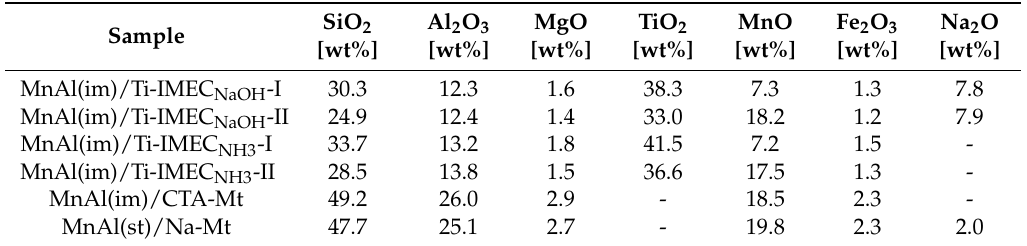
Table 1. XRF (X-ray fluorescence) determined chemical composition of the